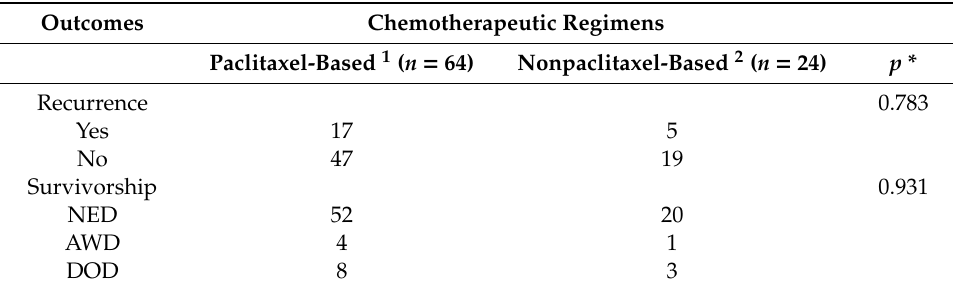
Table 2. Survivorship analysis between chemotherapies.